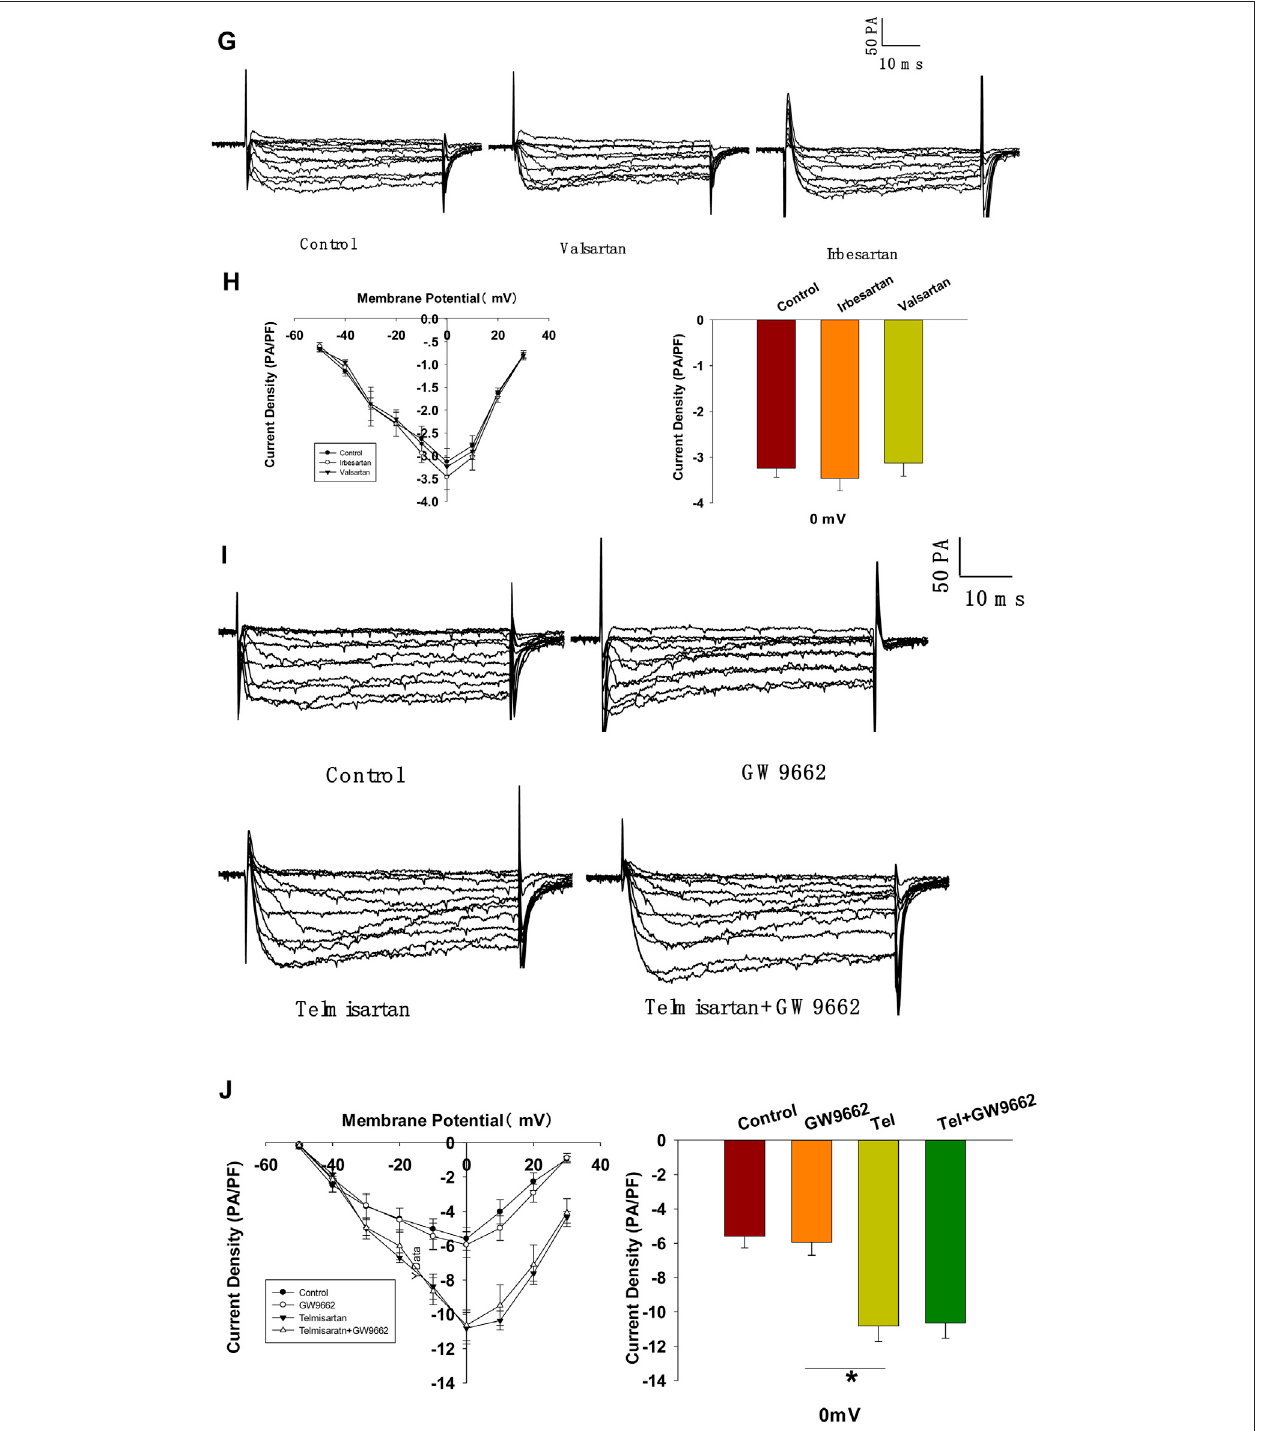
FIGURE 7 | depolarization (control, n (cid:1) 7 cells; telmisartan, n (cid:1) 8 cells). (E) Representative VGCC current traces recorded under treatment of 0.1 μ M azelnidipine (Az) alone or in combination with 10 μ M telmisartan (Tel). (F) Current-voltage relationship curves of VGCC and summary of the mean current density of Kv channels recorded at 0 mV depolarization (control, n (cid:1) 6 cells; Az, n (cid:1) 7 cells; Az+Tel, n (cid:1) 6 cells). (G) Representative current traces recorded with treatment of valsartan (10 μ M) and irbesartan (10 μ M) in β -cells. (H) Current-voltage relationship curves and the summary of the mean Ca 2+ current density recorded at 0 mV depolarization ( n (cid:1) 7 cells). (I) Representative current trances recorded under treatment of telmisartan (10 μ M) alone or in combination with GW9662 (10 μ M) in β -cells. (J) Current-voltage relationship curves and the summary of the mean Ca 2+ current density recorded at 0 mV depolarization (control, n (cid:1) 10 cells; GW9662, n (cid:1) 6; telmisartan, n (cid:1) 8 cells; telmisartan+GW9662, n (cid:1) 6cells).Thecellscomparedbetweenthegroupsineachgraphareisolatedfromthesameanimal.Allresultsarereportedasthemeans ± SEM.